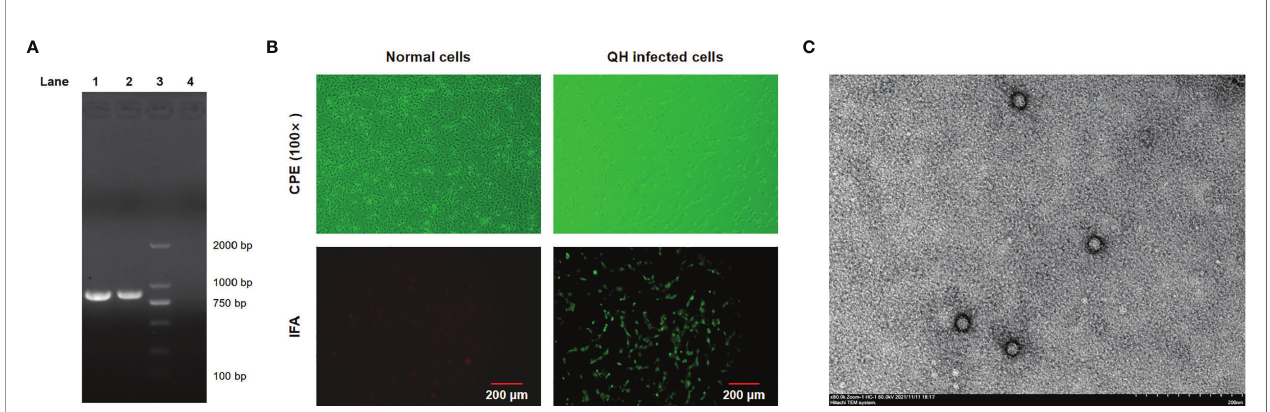
FIGURE 1 | Identi fi cation of FPV Giant panda/CD/2018 through IFA, TEM, and PCR. (A) PCR products were analyzed by 1.5% agarose gel. Lane 1, the isolate Giant panda/CD/2018; Lane 2, FPV prototype CU-4; Lane 3, DL 2000 DNA marker; Lane 4, nucleotide-free water (negative control). (B) The cytopathic effect (CPE)